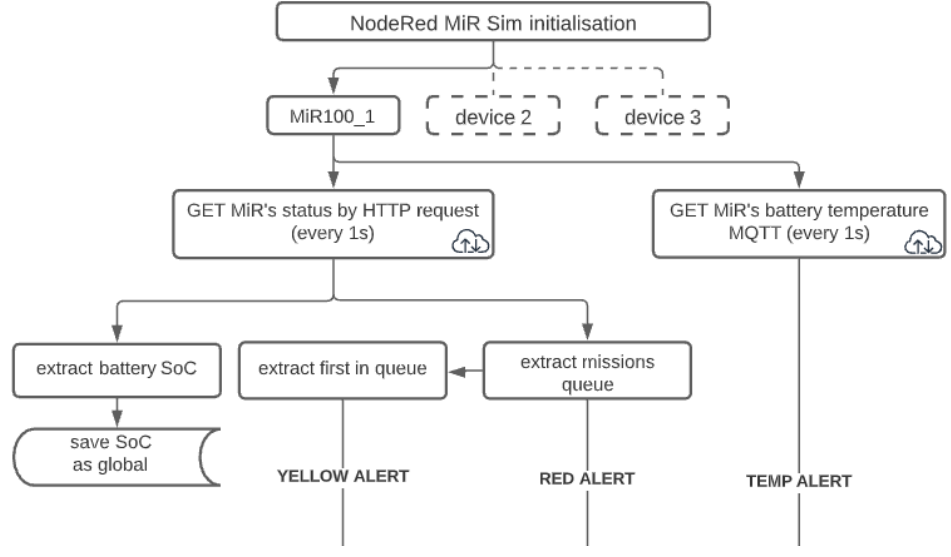
Figure 8. Data acquisition and pre-processing in the predictive monitoring system. YELLOW alert : acts as an early warning for the maintenance department to check for